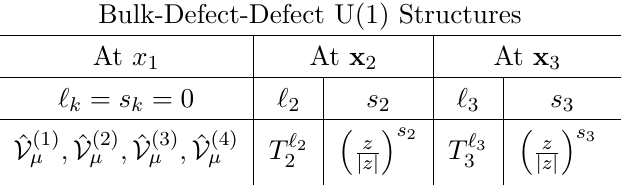
Table 2 . A table containing all the independent tensor structures appearing in a Bulk-Defect- Defect three-point function. Here ‘ and s are the parallel and transverse spin respectively of a k k defect operator inserted at x and all the bulk structures have zero defect spin. The definition of k each of these structures can be found in (B.3). There is also trace removing Kronecker